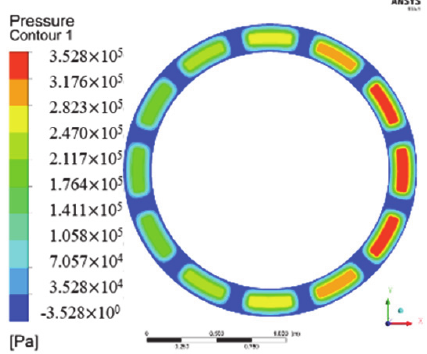
Figure 5. Cloud diagram of pressure distribution of biased oil film.